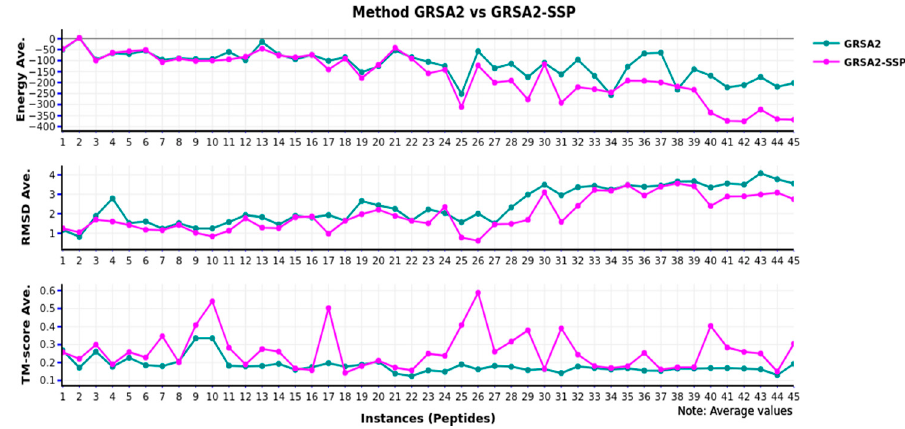
Figure 5. Comparison of GRSA2 versus GRSA2-SSP.